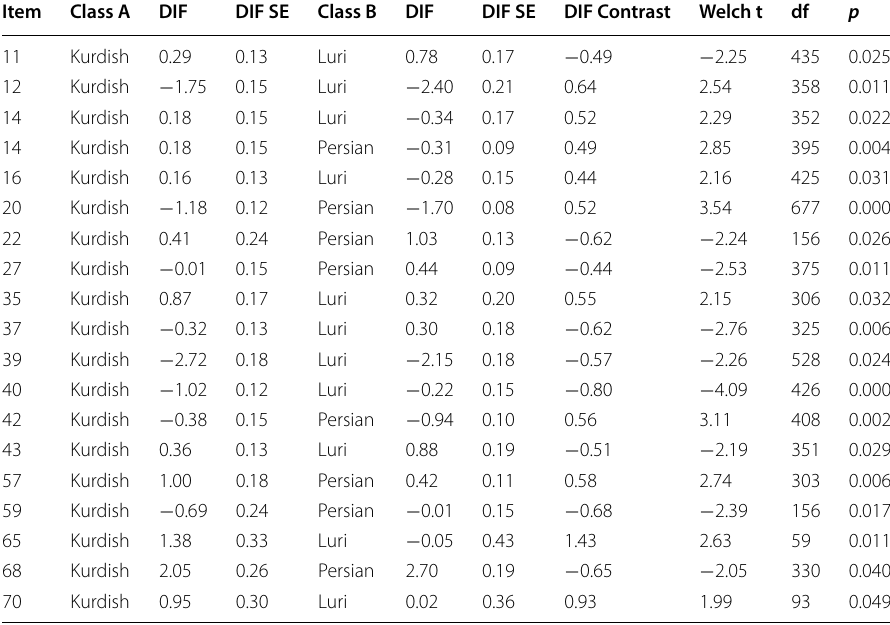
Table 13 Results of uniform DIF analysis of items (IUUESEE 2019)